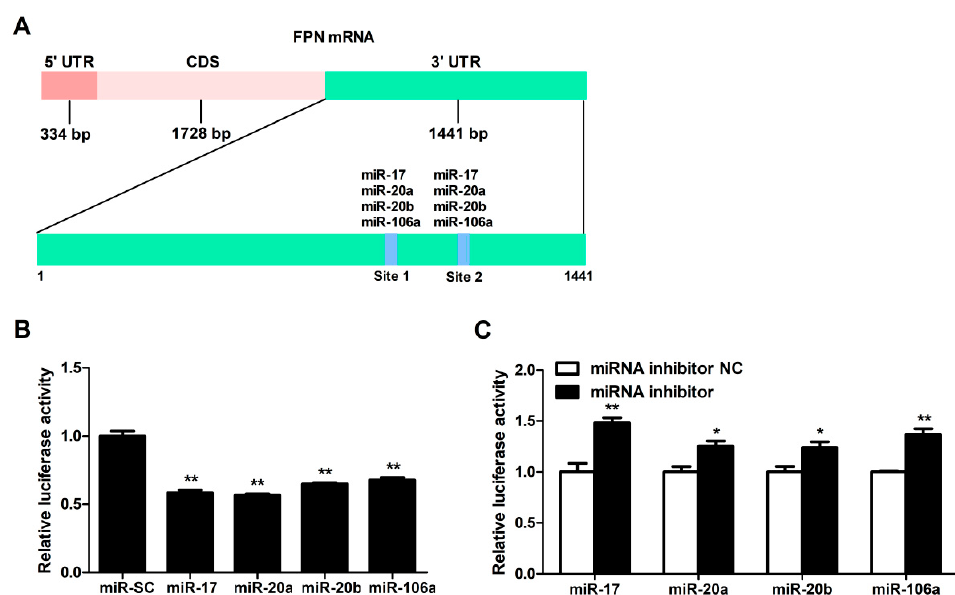
Figure 2. FPN mRNA is the target of candidate miRNAs. ( A ) Prediction of binding sites for miR-17, miR-20a, miR-20b, and miR-106a on the FPN 3 ′ UTR by bioinformatics algorithms. ( B ) FPN 3 ′ UTR Luciferase reporter activity was measured 24 h after transfections of miR-17, miR-20a, miR-20b, miR-106a and miR-NC in HCT116 cells. ( C ) Fold change in luminescence of FPN 3 ′ UTR luciferase reporter of miR-17, miR-20a, miR-20b, and miR-106a inhibition relative to control (miRNA inhibitor NC) for 24 h. Values were expressed as means ± SEM, n = 4 in each group, * p < 0.05, ** p < 0.01.